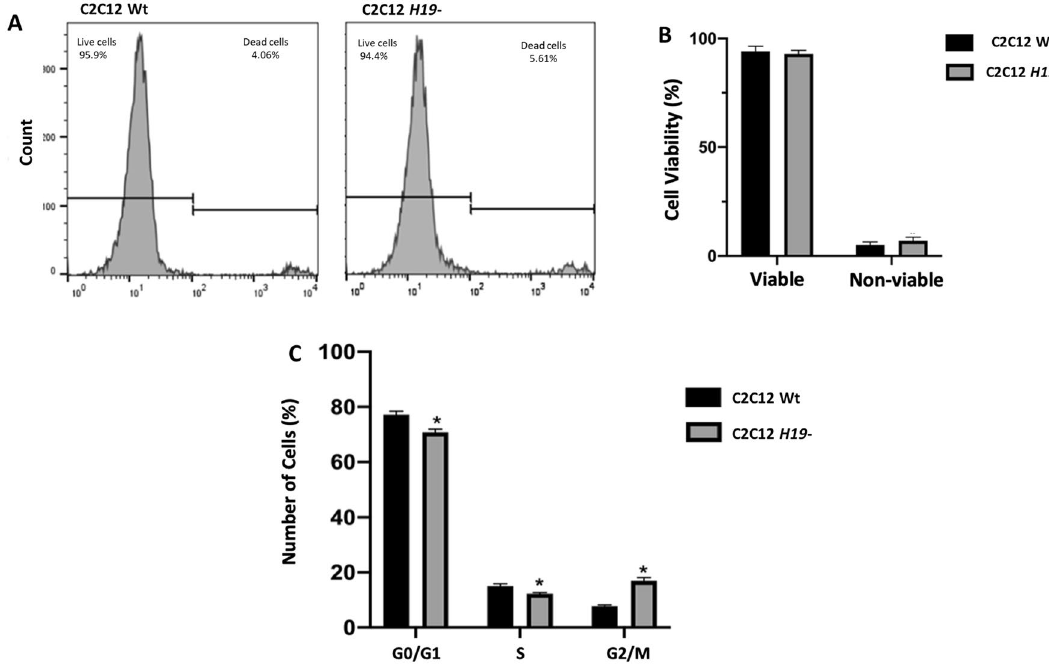
Figure 4. Flow cytometry viability and cell cycle analysis. Cell viability was not altered in the C2C12 H19- cells; ( A ) Graphical representation and ( B ) Percentage of viable and non-viable cells in Wt and H19- cells. ( C ) Cell cycle was altered in the H19- knockdown cells with a reduced percentage of cells in G0/G1 ( p = 0.0003) and S ( p = 0.001) phases and increased percentage of cells in G2/M ( p <